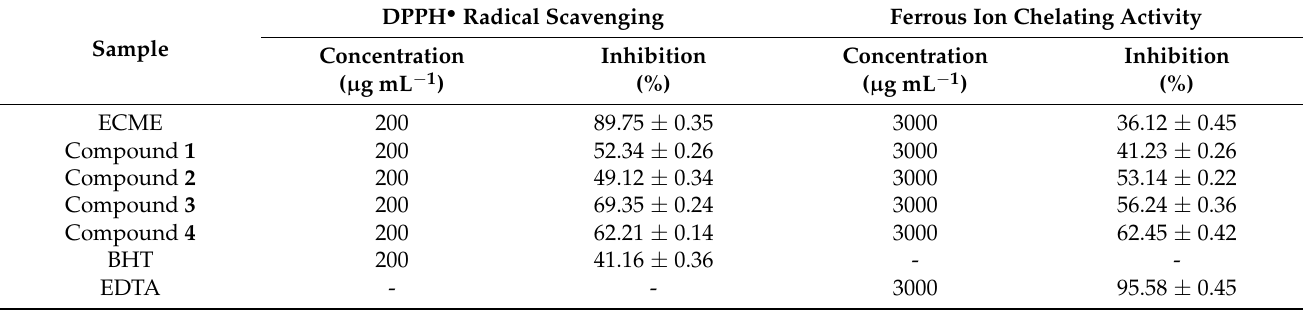
Table 2. Free radical scavenging (DPPH • ) and ferrous ion chelating (FIC) activity of ECME and isolated